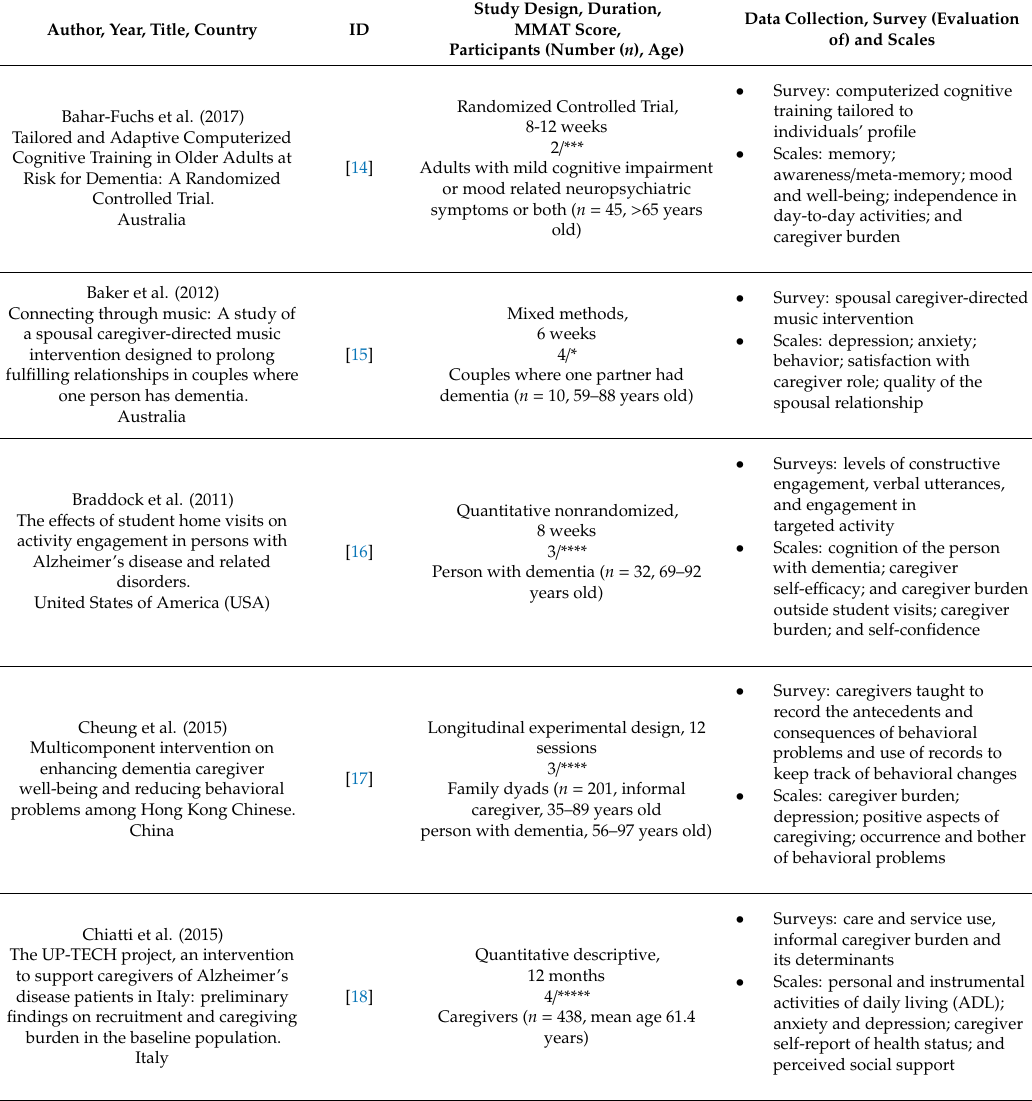
Table 1. Description of study details, design and quality